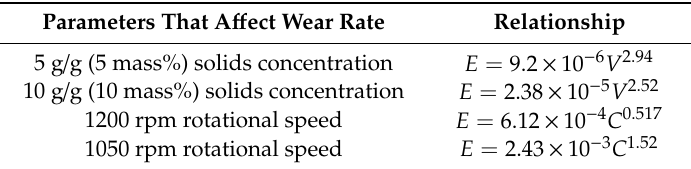
Table 2. The e ff ect of solids concentration and flow rate on wear rate.